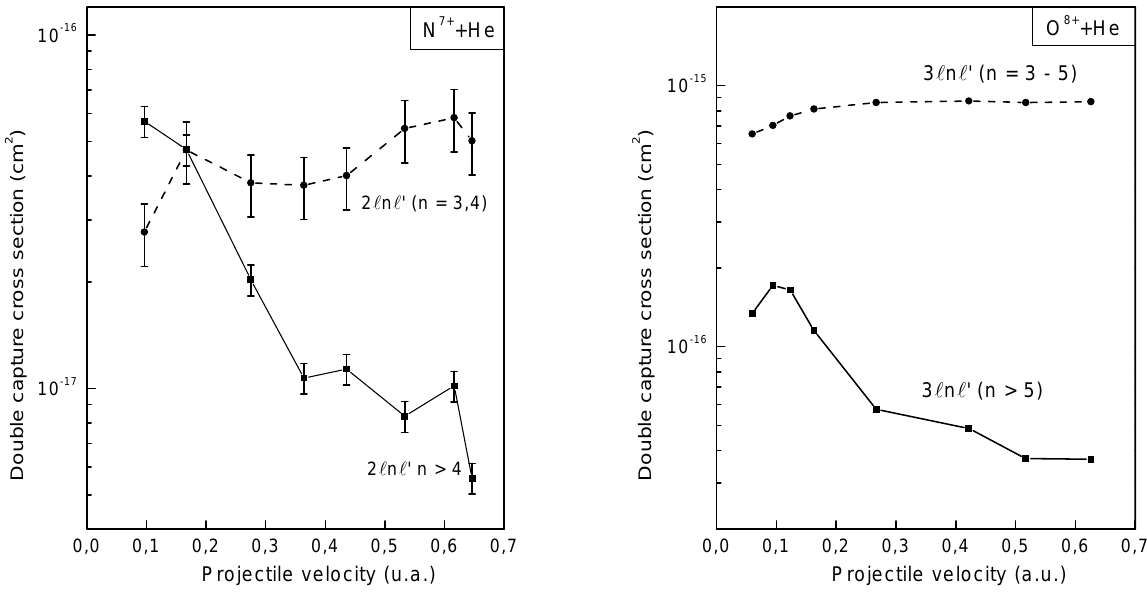
Figure 5. DC cross section for populating configurations of quasi equivalent and non equivalent 7+ 8+ electrons for N + He and O + He collisions as a function of the projectile velocity.